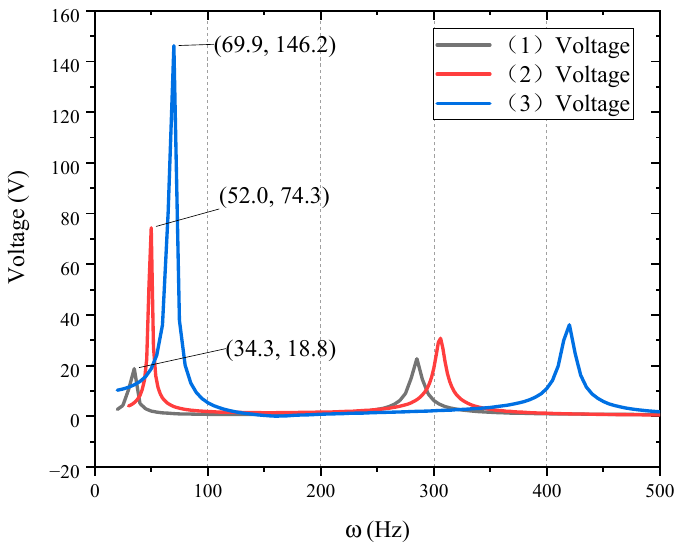
Figure 8. Control voltage of different piezoelectric patch position (Low-frequency zoom).